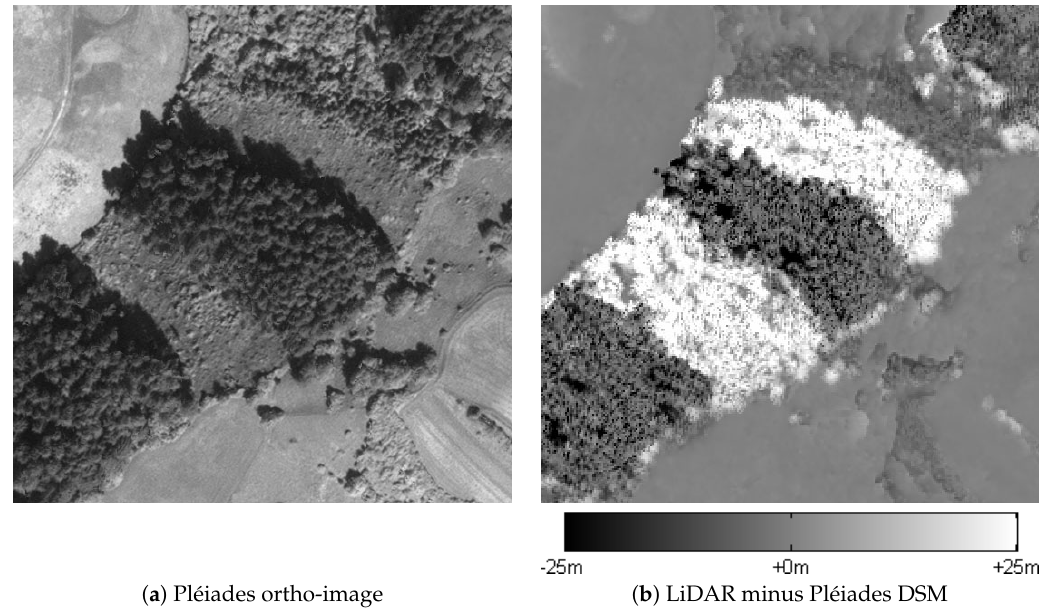
Figure 21. Detail view of a partly forested area at the Innsbruck stereo test